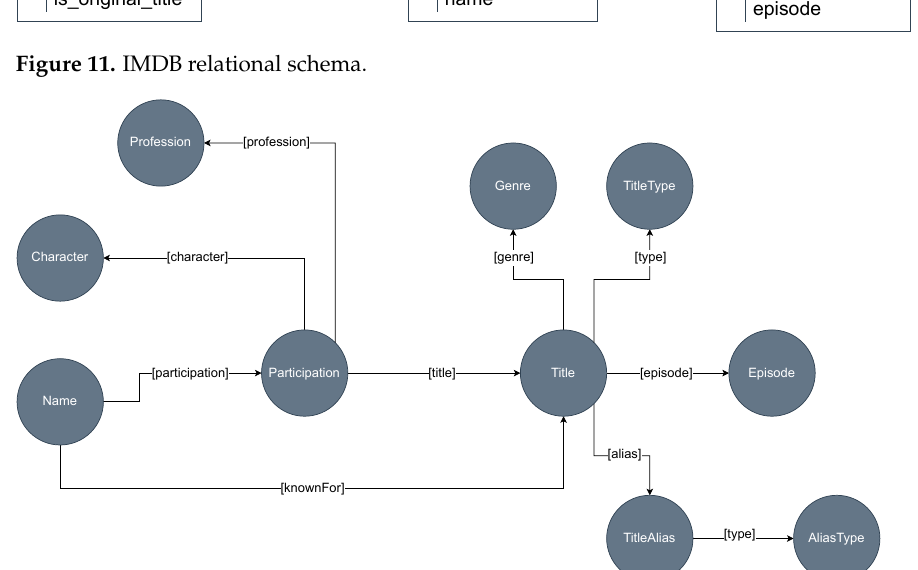
Figure 12. IMDB graph